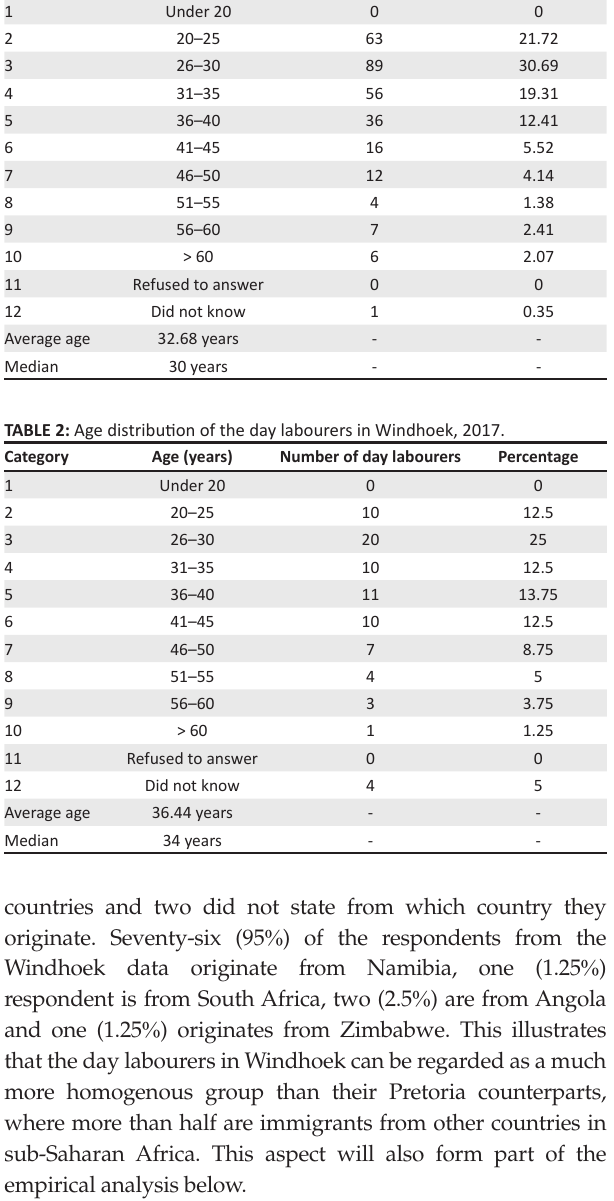
TABLE 1: Age distribution of the day labourers in Pretoria, 2015. Category Age (years) Number of day labourers